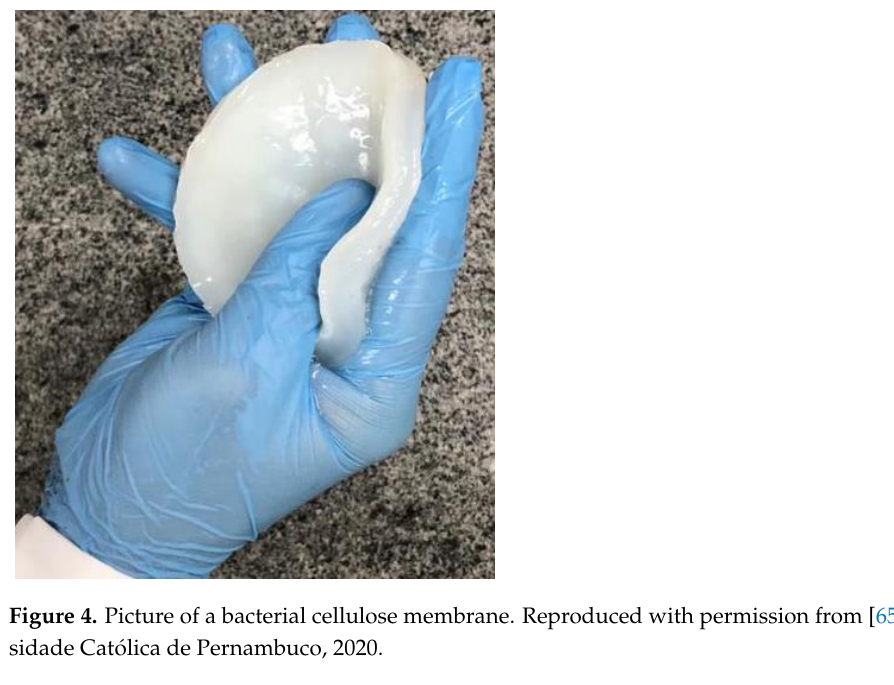
Figure 4. Picture of a bacterial cellulose membrane. Reproduced with permission from [65], Universidade Católica de Pernambuco, 2020.